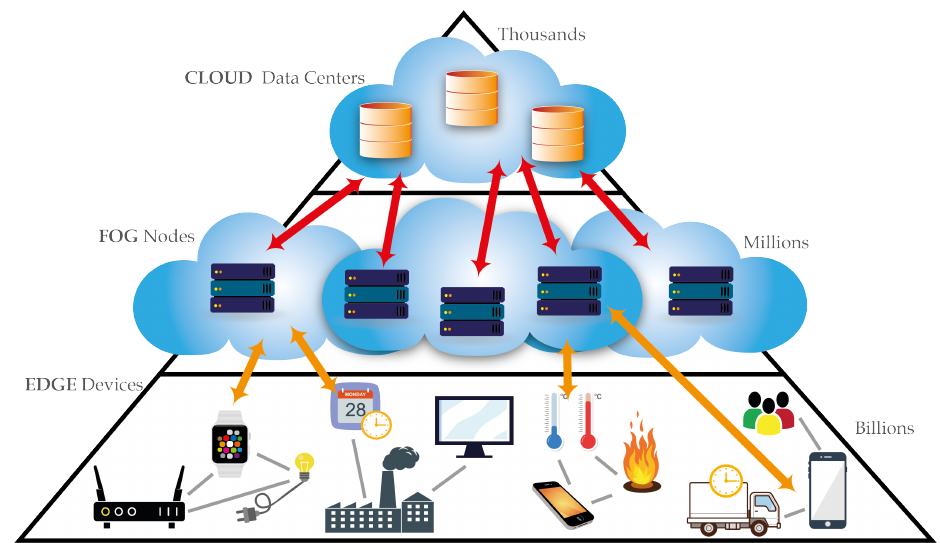
Figure 1. Hierarchical organization between edge, fog, and cloud